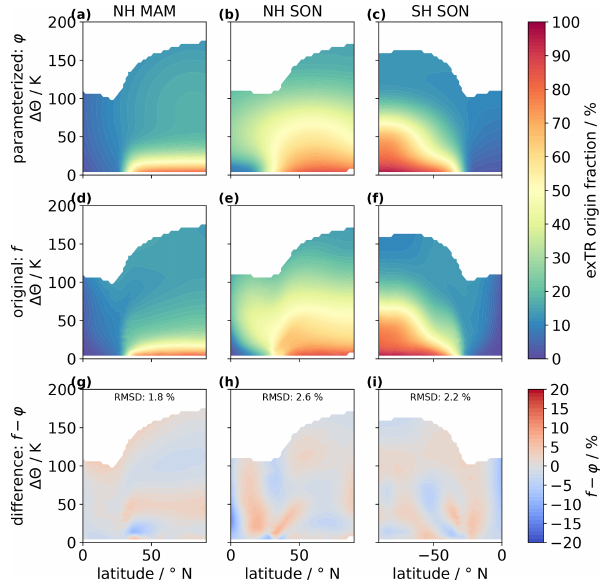
Figure 1. Comparing seasonal–hemispheric extra-tropical origin fractions parameterization ( ϕ , a–c ) and original CLaMS origin frac- tion simulation results from Hauck et al. (2020) ( f , d–f ). The dif- ference is shown in (g) – (h) . Only three selected season–hemisphere combinations are shown here (NH MAM, a, d, g ; NH SON, b, e, h ; SH SON, c, f, i ). The remaining distributions are shown in Fig. S1. Vertical coordinates are given in potential temperature above the 2PVU tropopause ( (cid:49)θ